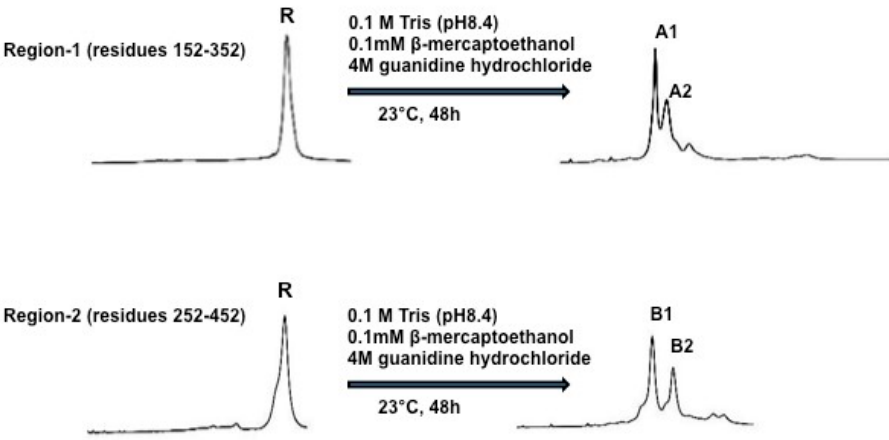
Figure 3. Refolding of Region-1 and Region-2 of PCSK9. Reduced Region-1 and -2 (1 mg/mL) proteins were incubated in 0.1 M Tris-HCl buffer (pH 8.4) containing hydroquinidine chloride (4 M) and β -mercaptoethanol (0.1 mM). The reaction was carried out at 23 °C for 24 h. Samples were analyzed and